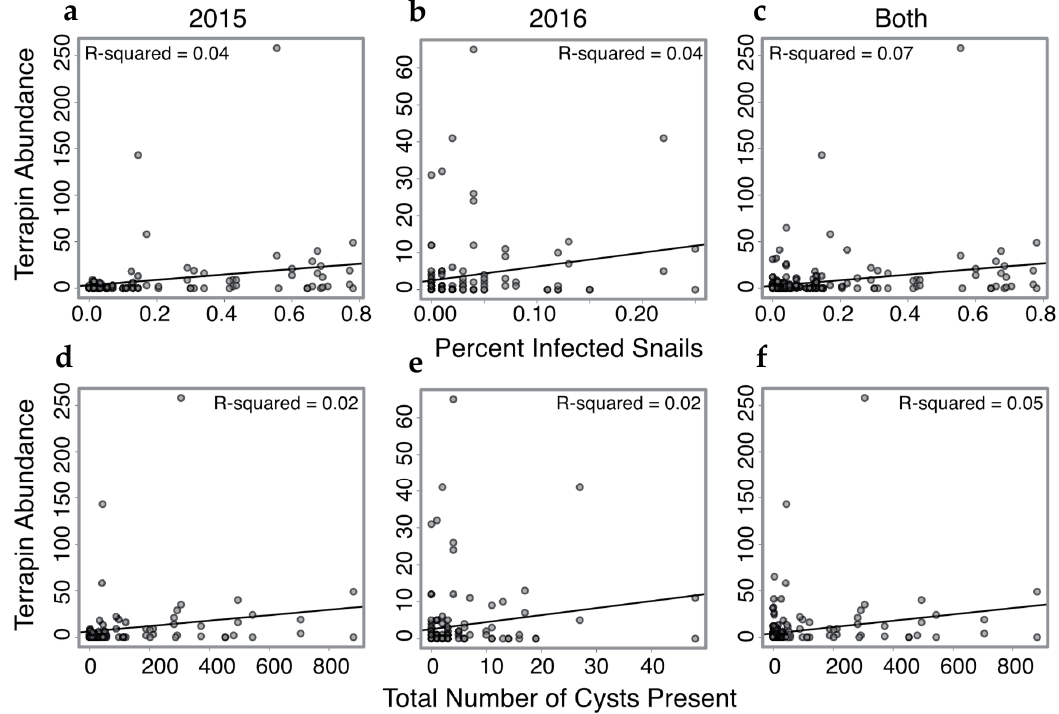
Figure 4. Bivariate plots of terrapin abundance, from headcount surveys, and trematode abundance measured using the percent of infected snails ( a – c ) and the total number of cysts on snails ( d – f ).